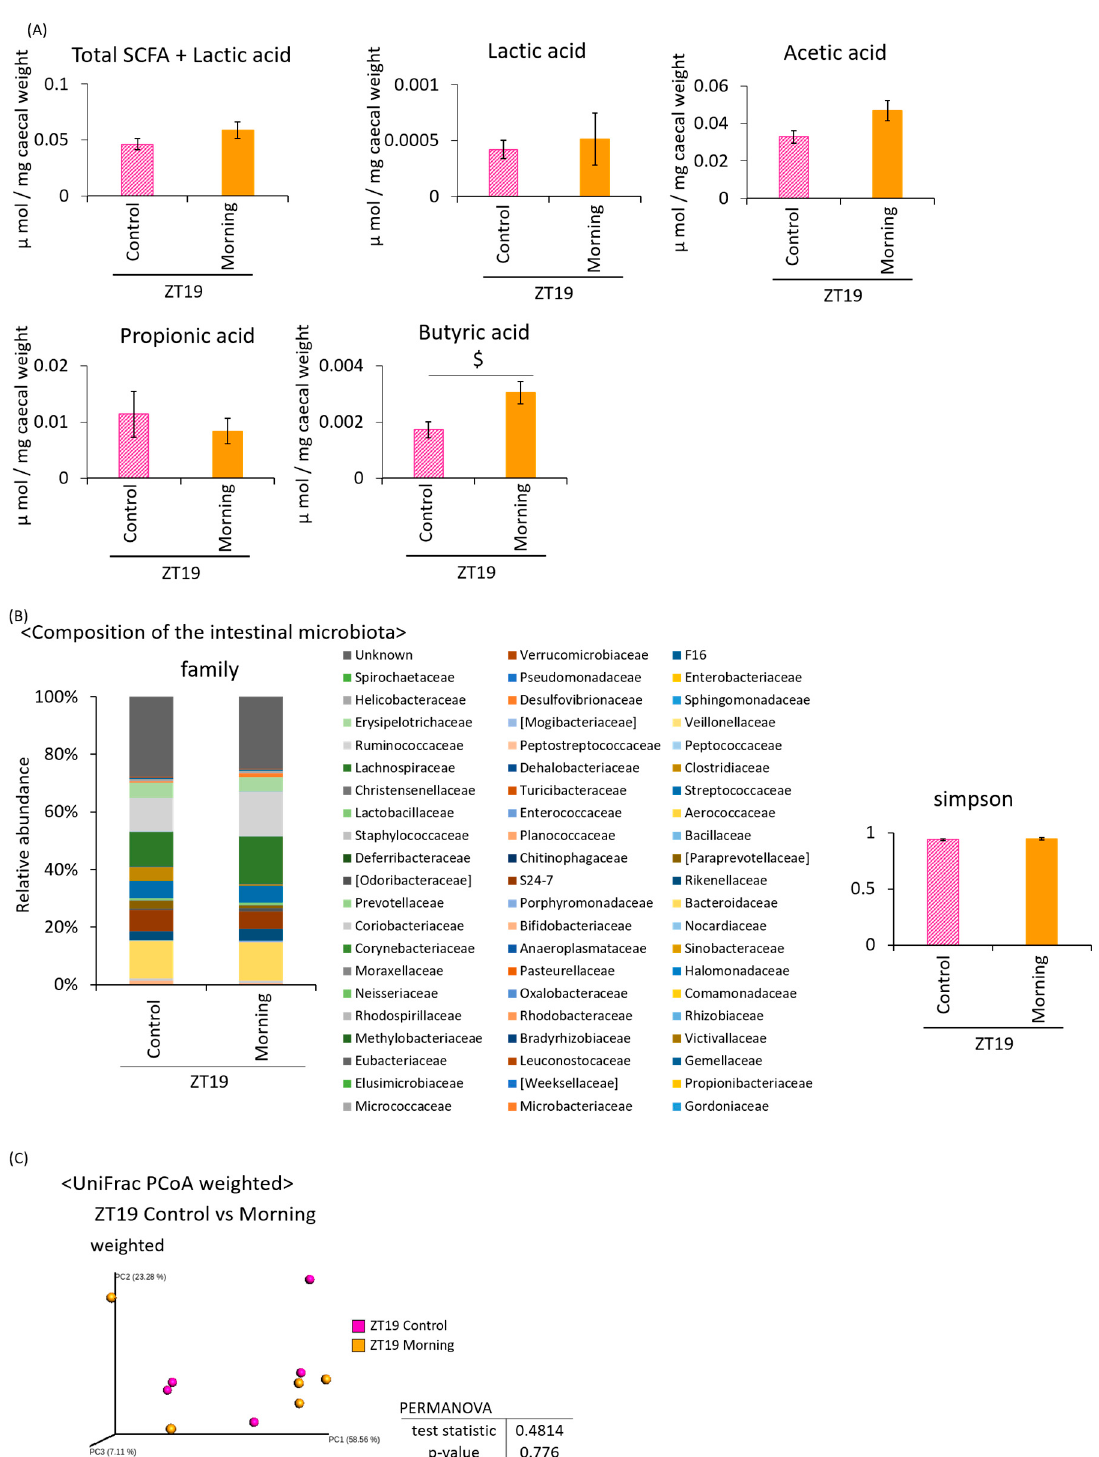
Figure 6. There were no significant differences between the cellulose- and A. lappa -intake groups with a small amount of A. lappa morning intake Effect of the small volume intake of A. lappa in the morning on the intestinal microbiota. ( A ) SCFA component and lactic acid was measured from caecal contents by GC-FID. ( B ) Composition of the intestinal microbiota and α -diversity. ( C ) UniFrac PCoA weighted of intestinal microbiota. All data are represented as mean ± SEM ( n = 5 for each group). $ p < 0.05, evaluated using the t-test. Morning group took A. lappa during ZT12–ZT15 and was sacrificed at ZT19.